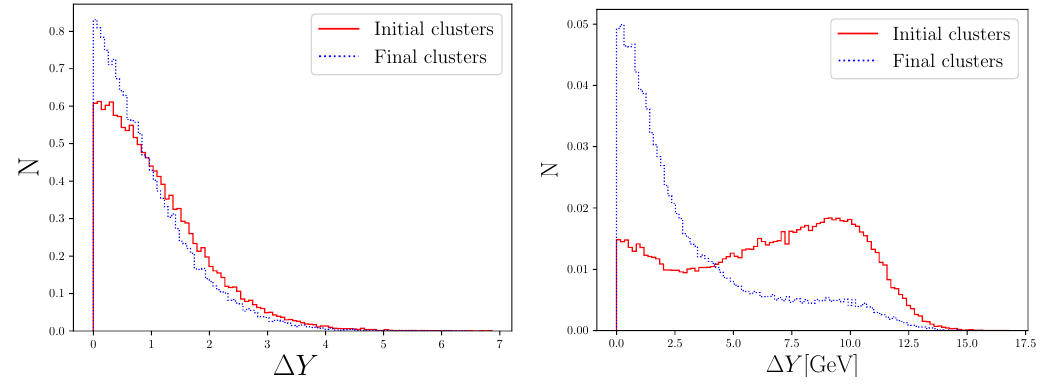
Figure 5 . Histogram of the (cid:1) Y values for the quark anti-quark pairs of the original clusters that were reconnected and the (cid:1) Y value of the quark anti-quark pairs of the reconnected clusters. (a) RAMBO Phase space. (b) UA5 phase space with random colour